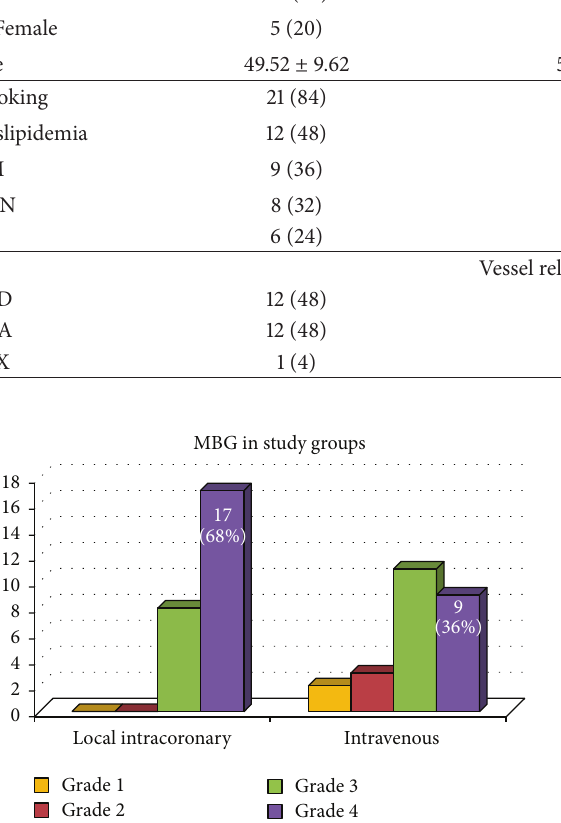
3.3. Myocardial Reperfusion. In the infusion catheter